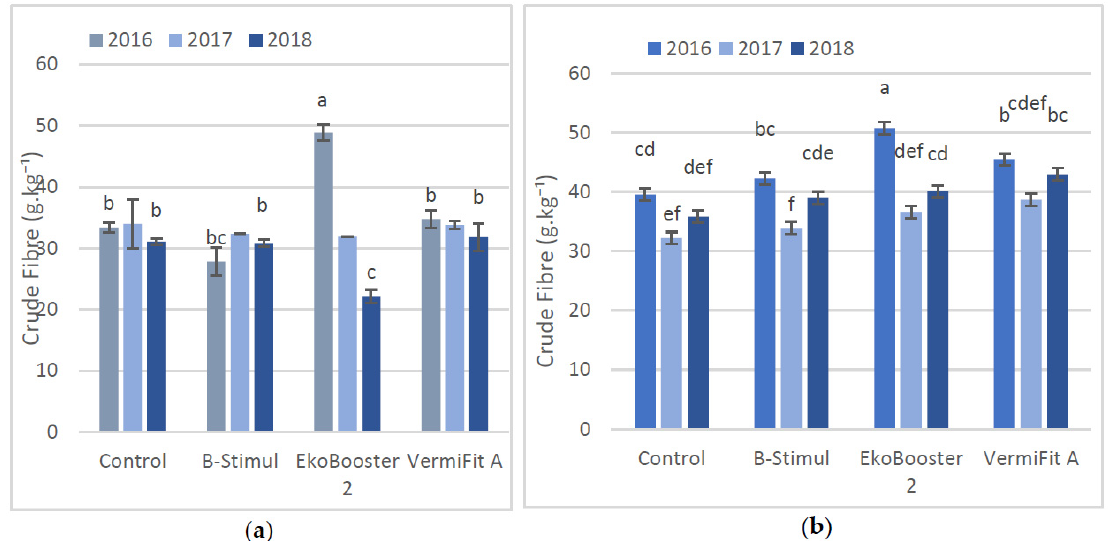
Figure 3. Crude fibre content in onion bulbs of Stuttgarter Riesen ( a ) and Rote Laaer ( b ). The data are the mean values of four replications. Different letters denote significant differences (Fisher’s test, p ≤ 0.05). Vertical bars denote standard error.